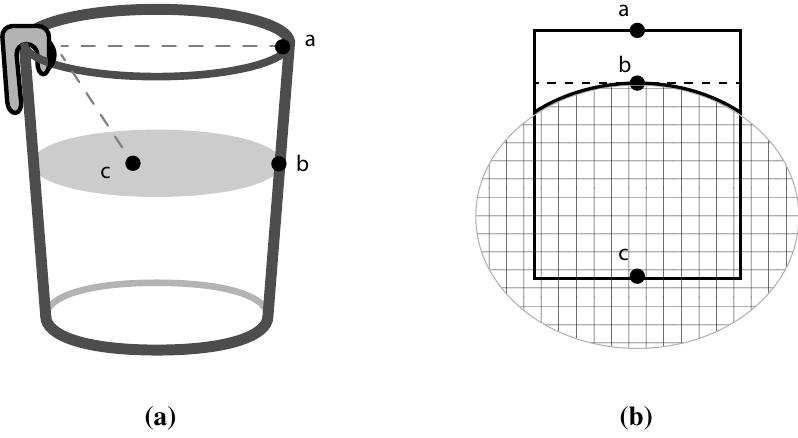
Figure 2. ( a ) Camera setup on the vessel; ( b ) Illustration of the image